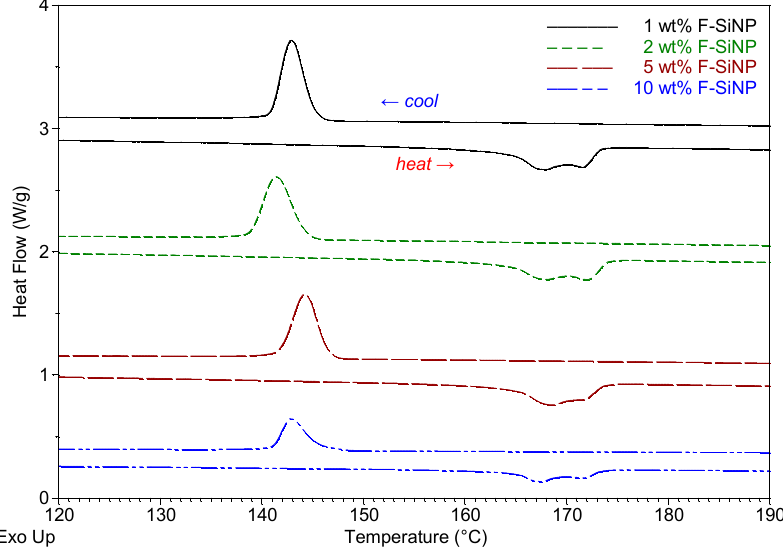
Figure 2. Overlay of DSC heating and cooling after third cycle at various wt % F-SiNP loadings in PVDF.